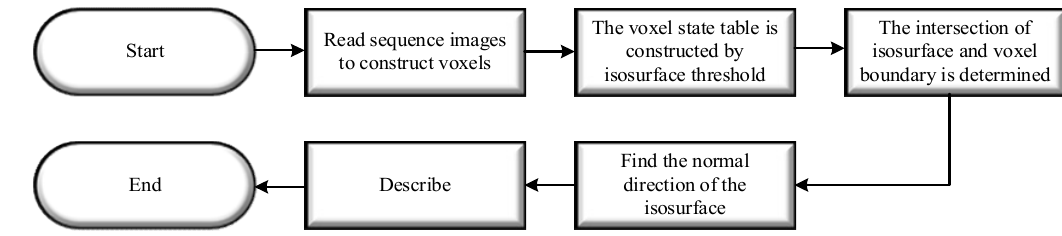
Figure 13. Algorithm flow of moving cube.